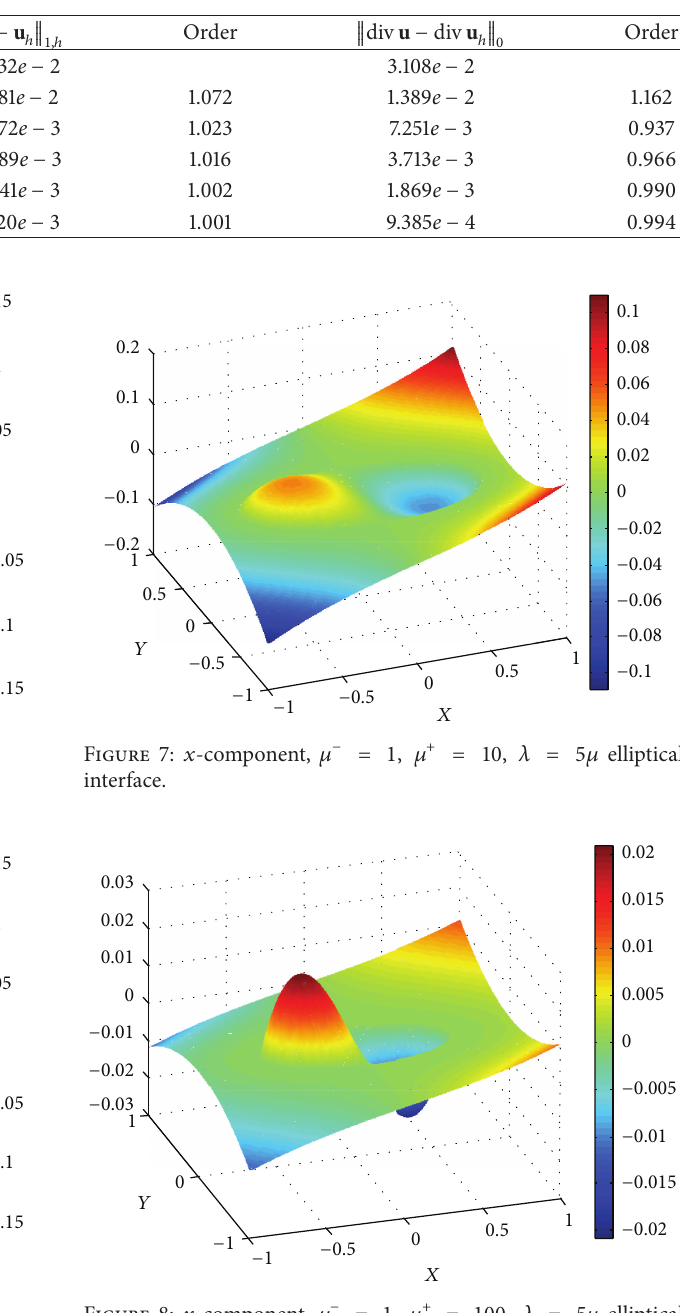
Table 6: 𝜇 − = 1 , 𝜇 + = 100 , 𝜆 = 5𝜇 , and elliptical interface.